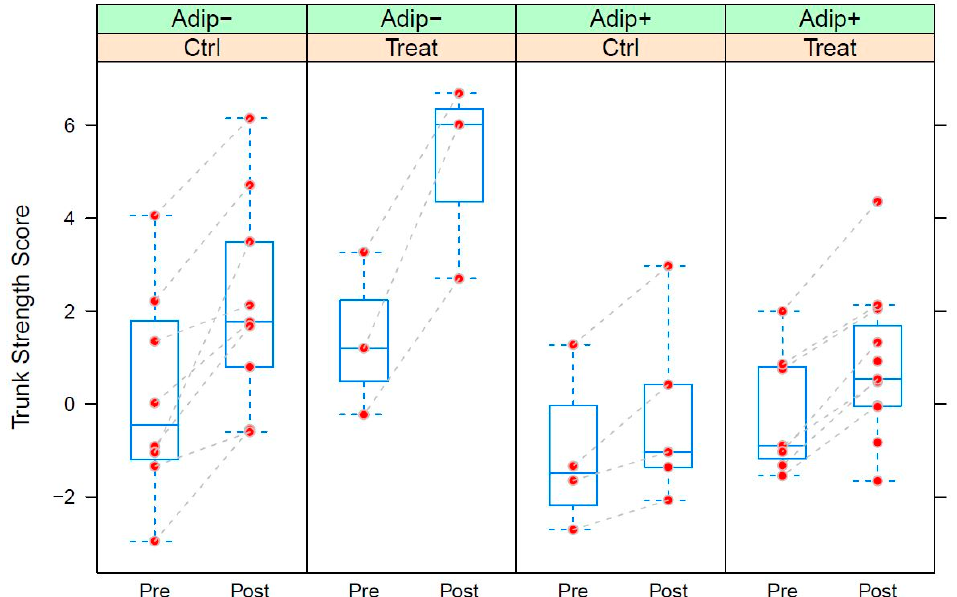
Figure 6. Box-plots of the Trunk Strength Score (TS) calculated from the strength data of study B grouped by supplementation (Ctrl: control group; Treat: treatment group) within adiposity status (Adip − : BMI < 30, Adip+: BMI >= 30). Pre: measurement before training intervention; Post: measurements after training intervention. TS corresponds to the 1st principal component extracted from the strength data. See text for detailed explanation of the score. See caption of Figure 4 for details of the